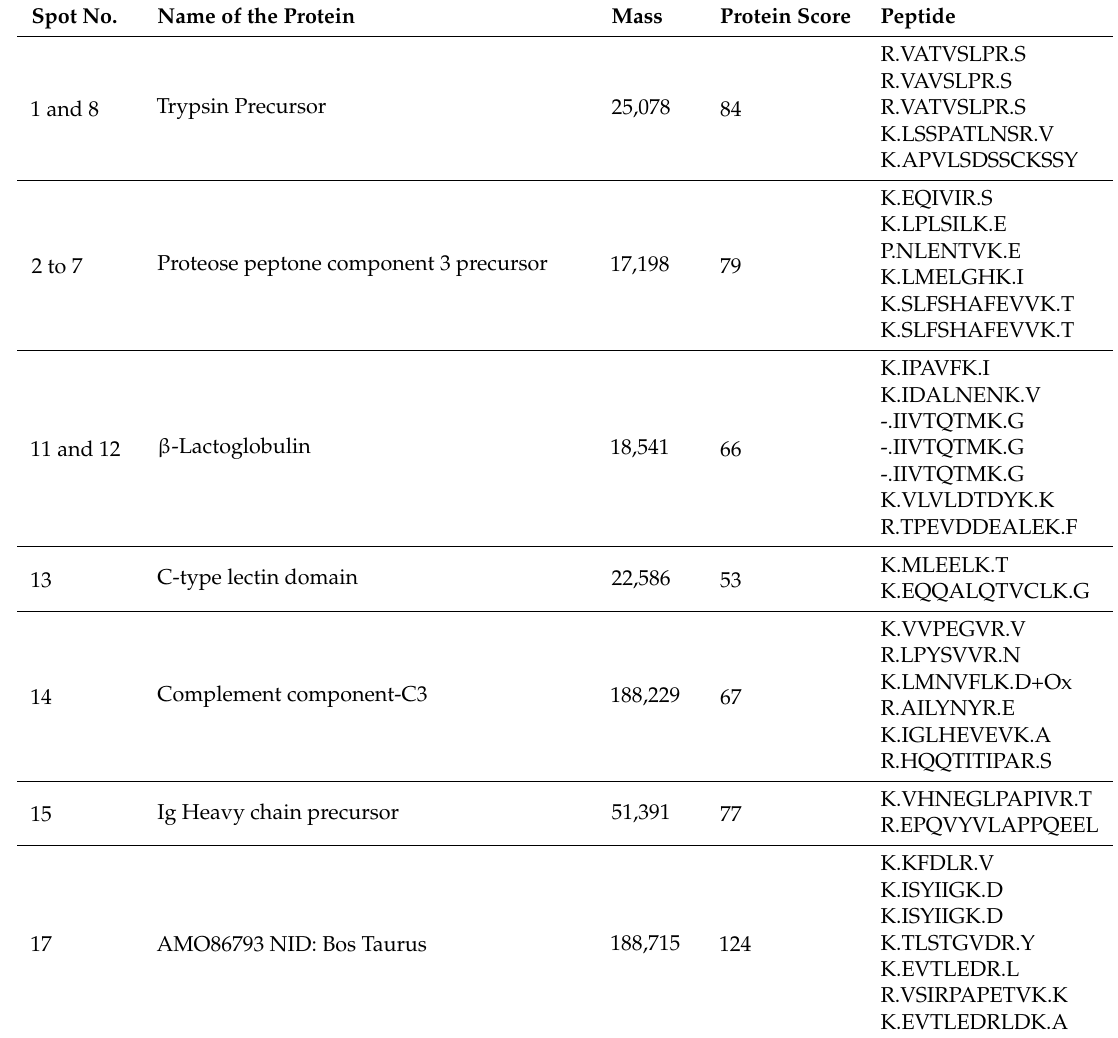
Table 1. MASCOT search results of peptide mass